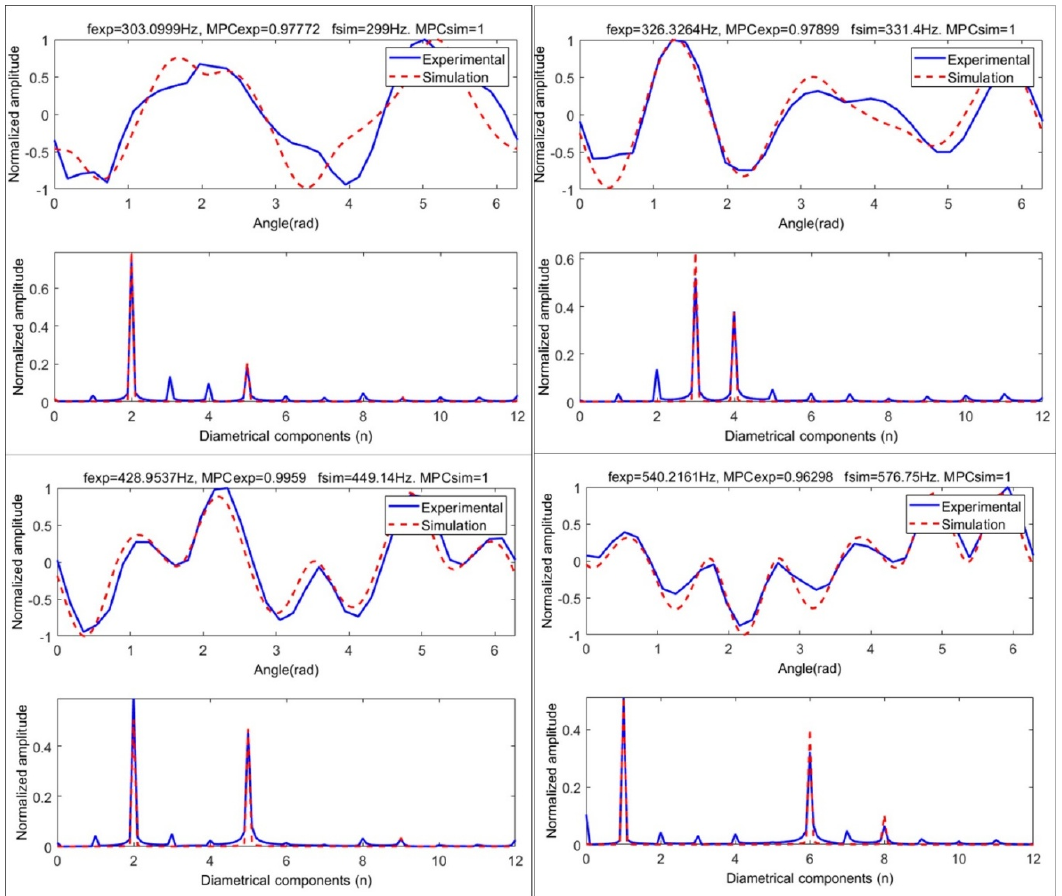
Figure 13. Diametrical modes analyzed with experimentation and simulation. Peripheral deformation and mode shape decomposition.